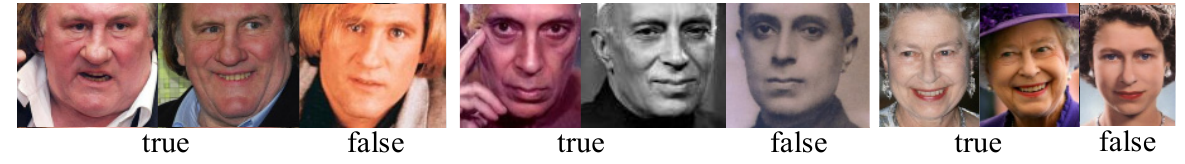
Figure 10. The image clustering performance at different ages.